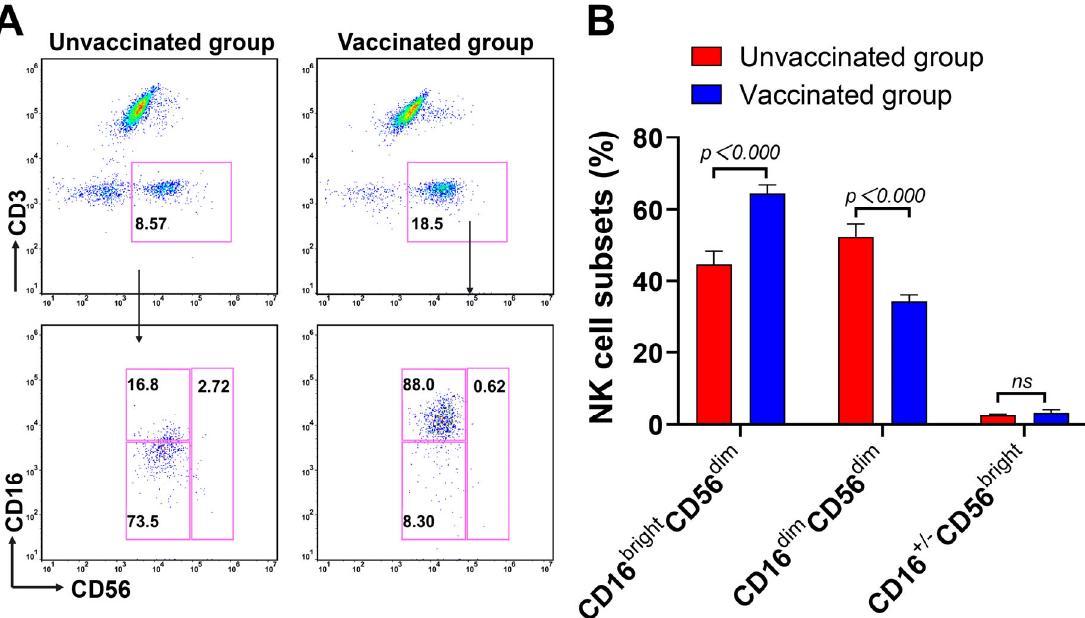
Figure 2. Comparison of the NK cell subsets between the unvaccinated and vaccinated groups. ( A ) The expressions of CD16 and CD56 on NK cells were measured using fl ow cytometry. ( B ) Bar graph of the proportions of the NK cell subsets. Unvaccinated group, n = 96; vaccinated group, n = 347. All p -values were two-tailed, and di ff erences with p < 0.05 were considered statistically signi fi cant. ns , not signi fi cant.